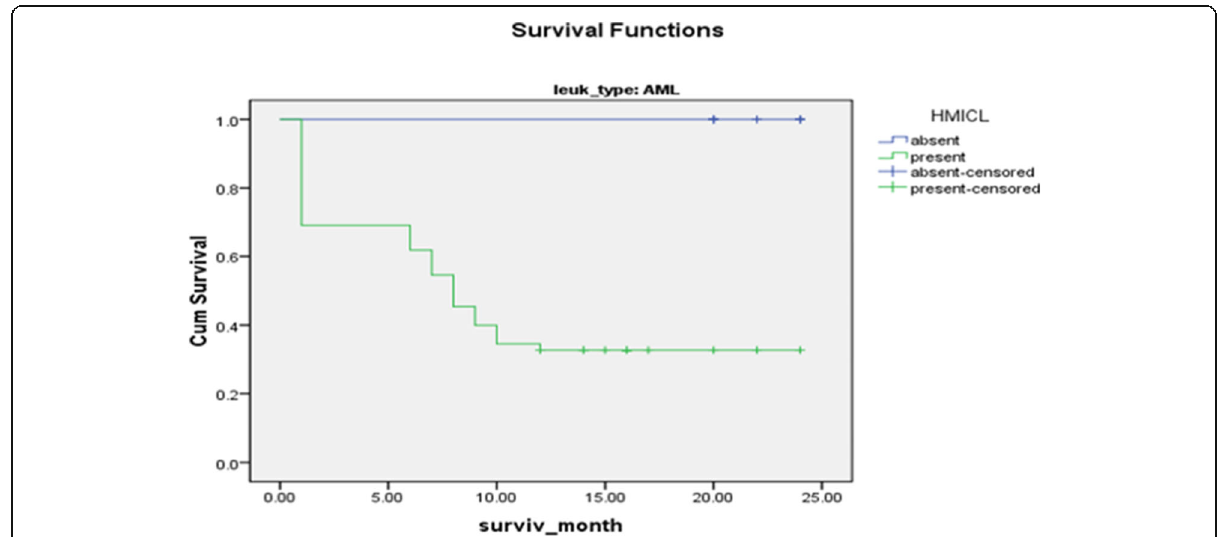
Fig. 2 Kaplan-Meier survival curve in AML patients with positive and negative hMICL receptor